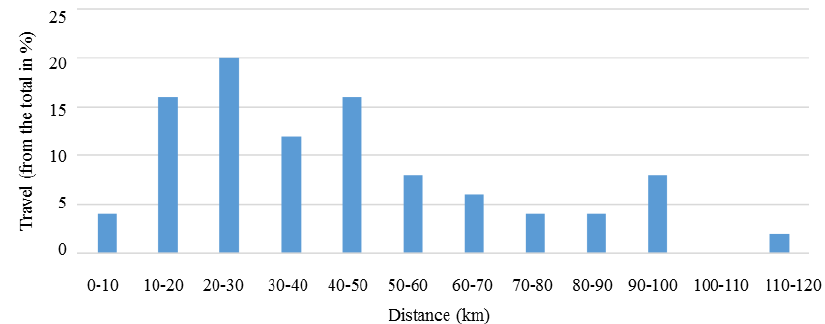
Figure 6. Distribution of distance traveled by EVs.